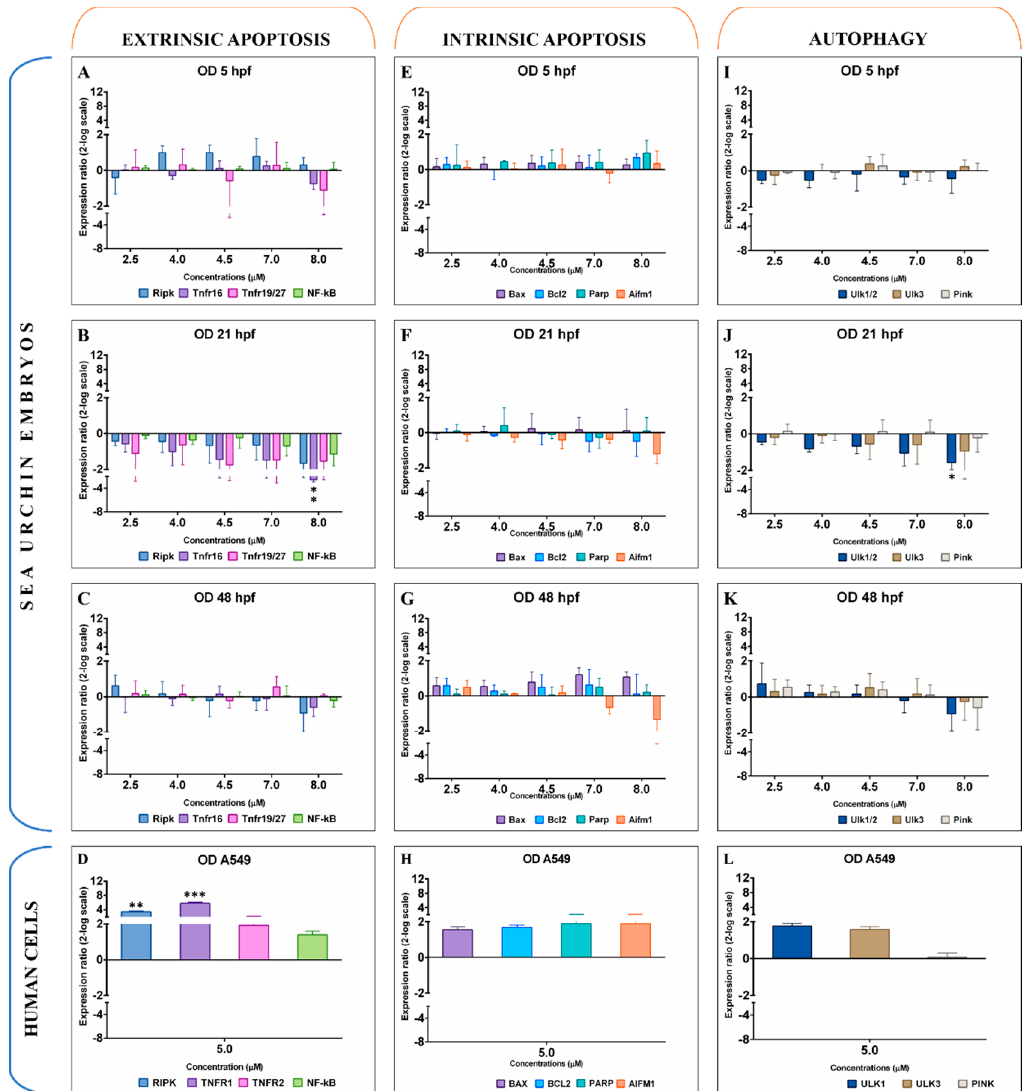
Figure 3. Gene expression levels of 11 genes belonging to extrinsic apoptosis ( A – D ), intrinsic apoptosis ( E – H ), and autophagy ( I – L ) in the sea urchin Paracentrotus lividus treated with 2.5, 4.0, 4.5, 7.0, and 8.0 μ M of octadienal for 5, 21, and 48 hpf and in A549 human cells treated with 5.0 μ M for 2 h. Samples obtained from three independent biological replicates were analysed by qPCR in technical triplicates. Data are reported as fold difference (mean ± SD), compared to controls without octadienal. Error bars represent the variation in biological replicates. Expression values greater were statistically analysed by Mann–Whitney U test and values were considered significant if the p -value was <0.05 (* for p -value <0.05; ** for p -value <0.01; *** for p -value <0.001).